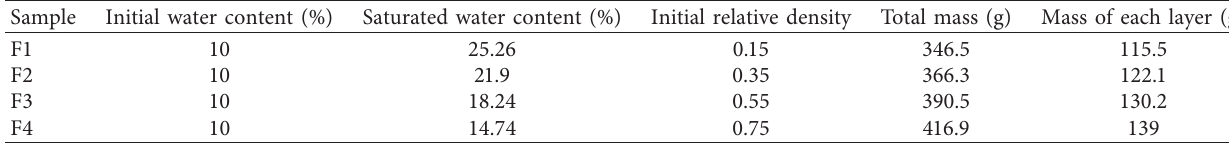
Table 2: Experimental design of gravelly